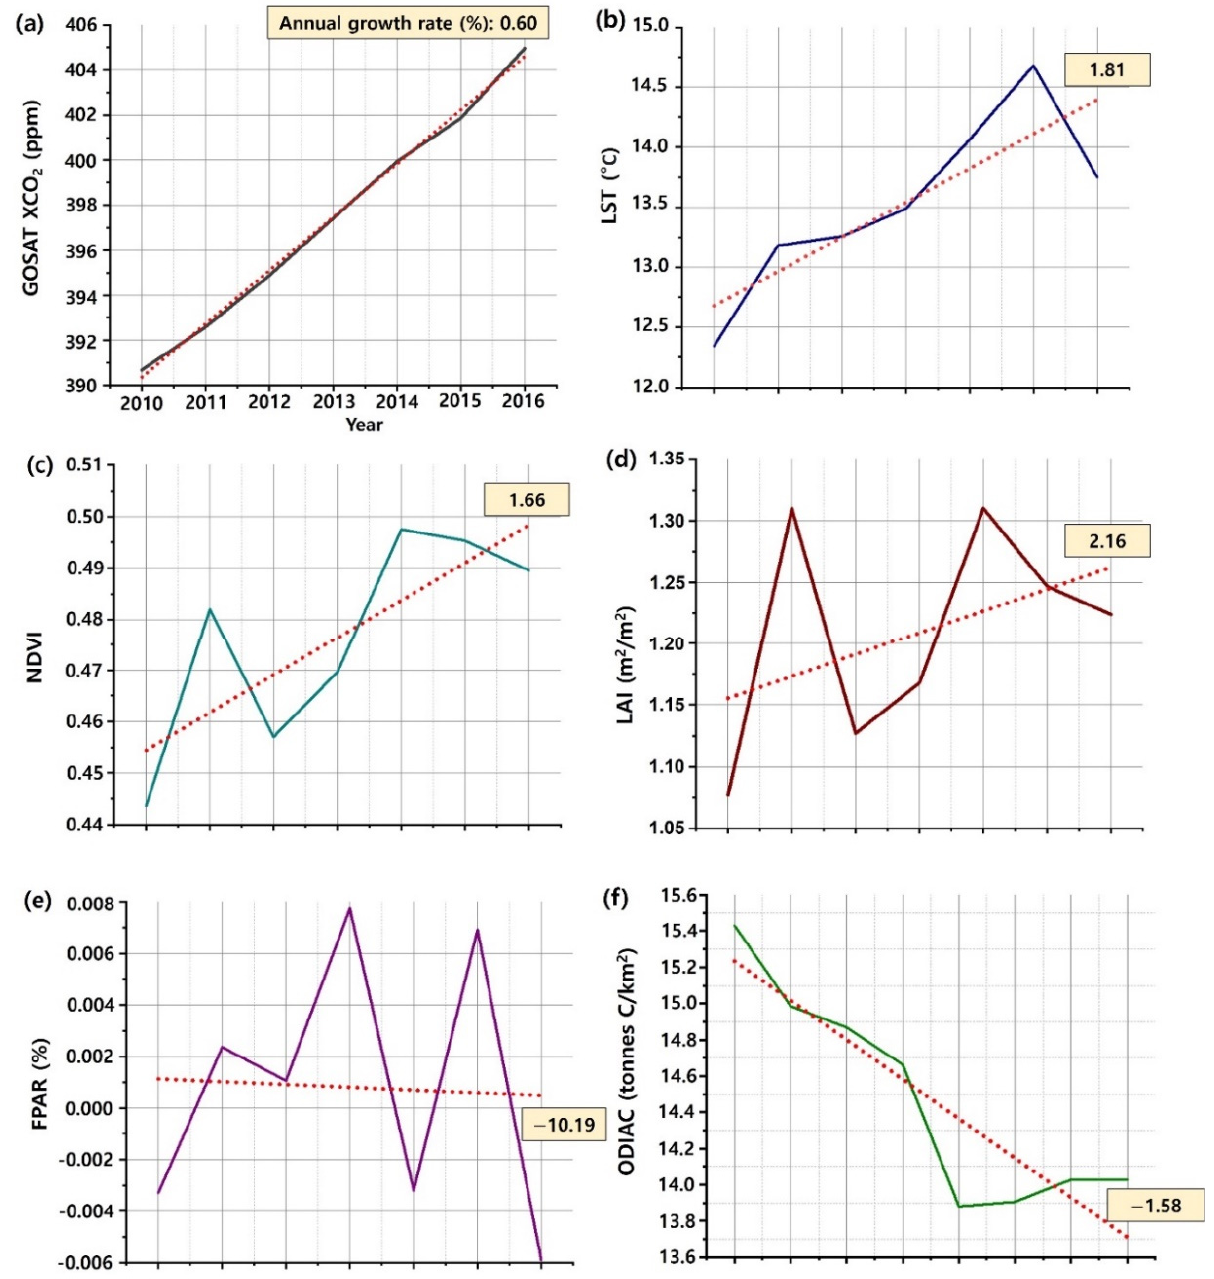
Figure 3. Annual trends of GOSAT XCO 2 and carbon uptake sources in Europe during 2010–2016. Red dotted lines are the trend lines used with the linear fit (x-axis: year). The years 2009 and 2017 are not presented in Figure 3 due to the lack of data for calculating the annual mean values. ( a ) GOSAT XCO 2 . ( b ) LST. ( c ) NDVI. ( d ) LAI. ( e ) FPAR. ( f ) Open-source Data Inventory for Anthropogenic CO 2 (ODIAC).